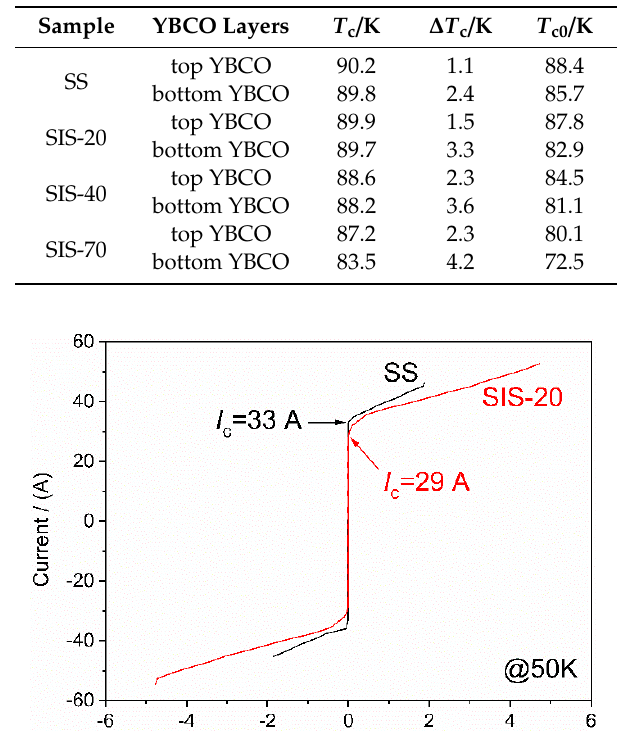
Table 2. Superconducting transition parameters of the YBCO layers in the YBCO / LAO / YBCO trilayer films.